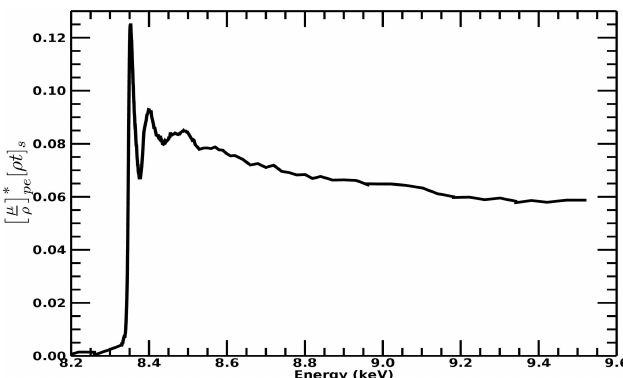
Figure 2 Published transmission spectra for the active Ni in the Ni i -pr complex, on an absolute scale, displaying the expected XAS spectral trend for absorption coefficients (Chantler et al. , 2015). These measurements were taken simultaneously on the same samples as Fig. 1. This illustrates the large differences in structure and spectral profiles of transmission data ( (cid:3) / (cid:4) )( (cid:4) t ) s from the fluorescence measurement, ð (cid:3)=(cid:4) Þ (cid:3) observed in many data sets. The standard error across the spectrum is of the order of 10 (cid:4) 4 in absolute units or <0.01% on the raw